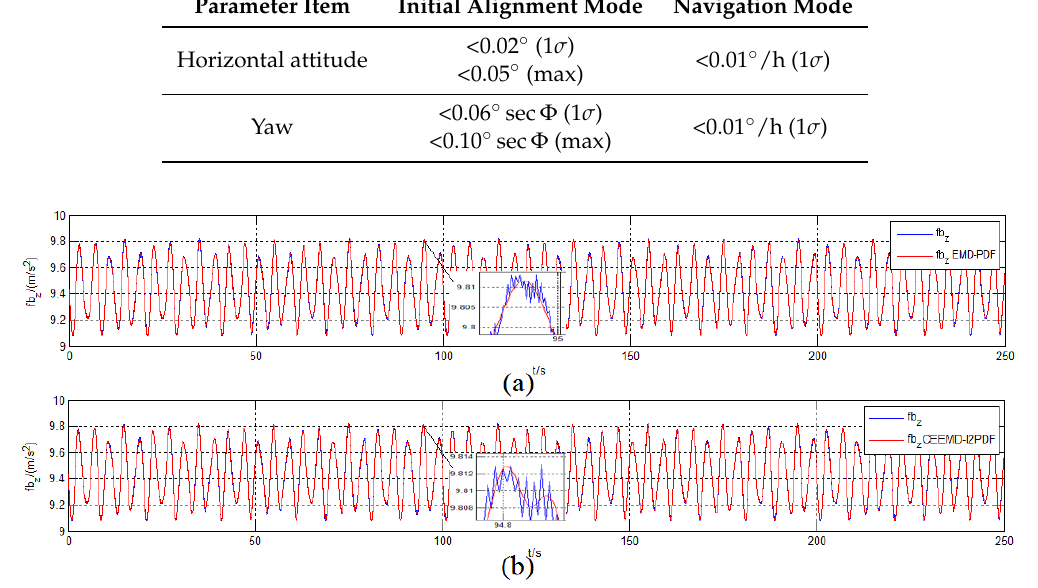
Figure 10. Denoising results of ˜ f b in the turntable test. ( a ) EMD-PDF method; ( b ) CEEMD- l 2 PDF z